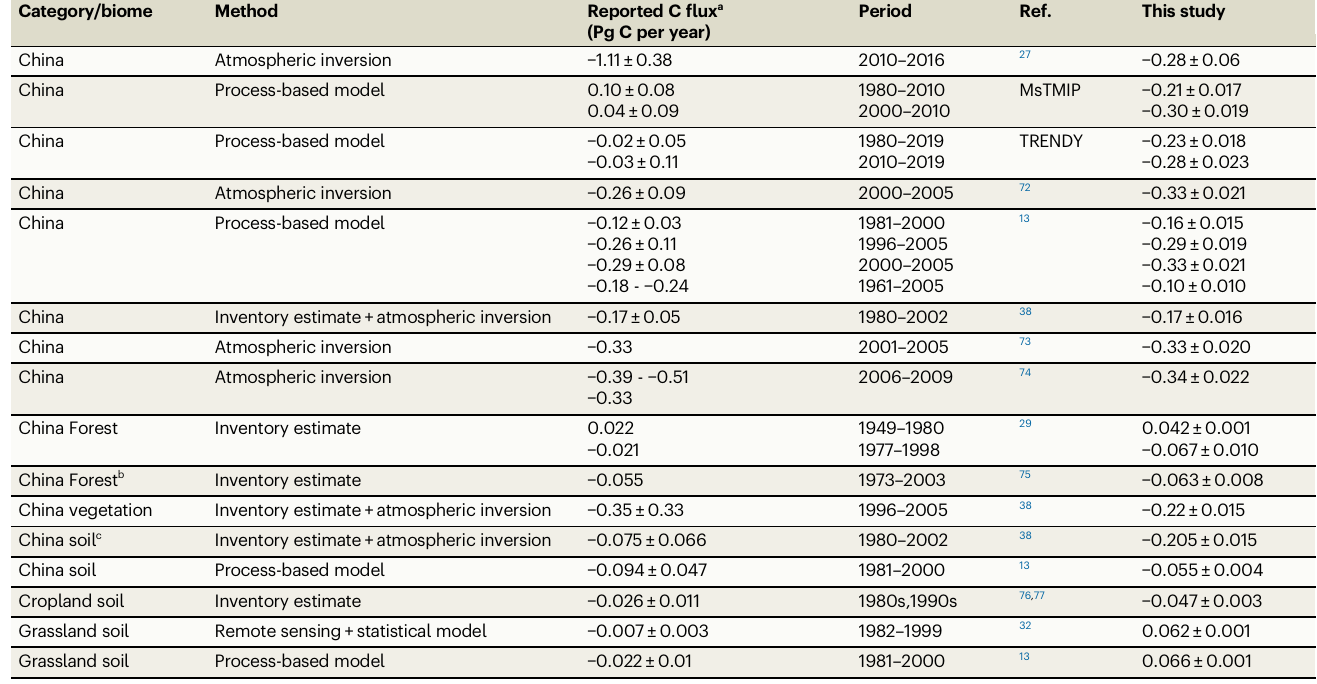
Table 1 | Comparison of reported carbon fl uxes from various biomes in China